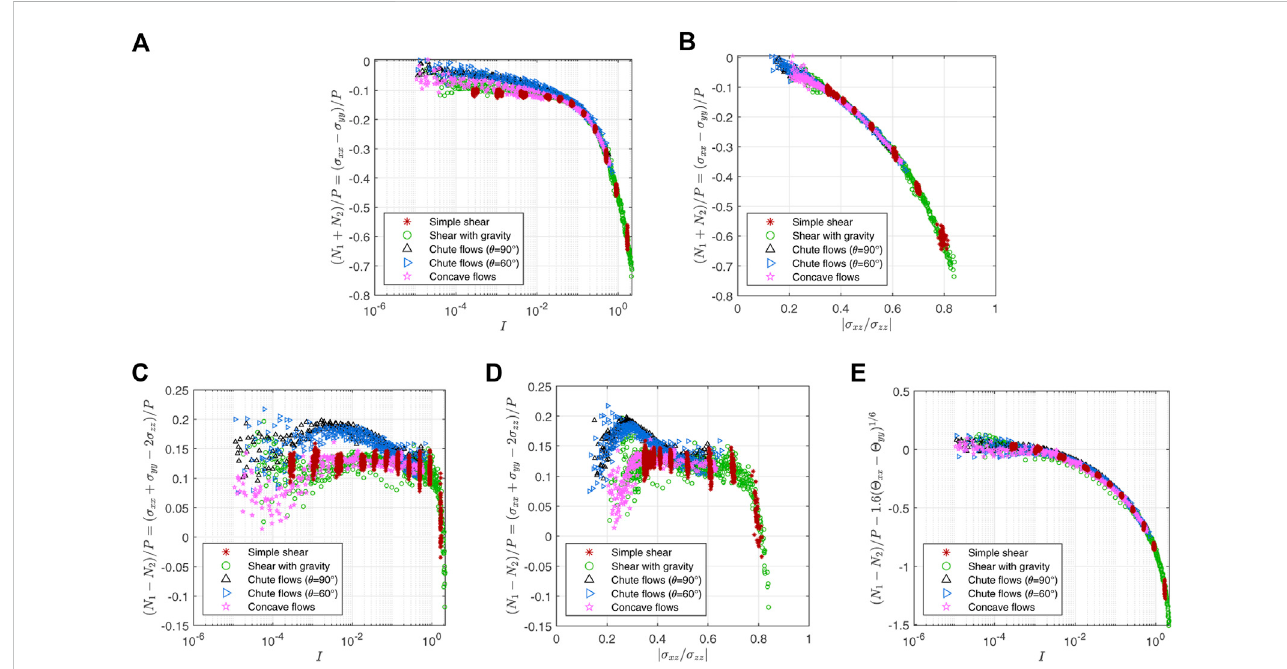
FIGURE 9 Sum and difference of the fi rst ( N 1 ) and second ( N 2 ) normal stress differences divided by pressure: ( N 1 + N 2 )/ P = ( σ xx − σ yy )/ P exhibits non-locality when plotted against I (A) , but it forms a collapsed line when plotted against | σ xz / σ zz | (B) . Plotting ( N 1 − N 2 )/ P = ( σ xx + σ yy − 2 σ zz )/ P against (C) I or (D) | σ xz / σ zz | does not form a data collapse. (E) Subtracting an arbitrary function 1 . 6 ( Θ xx − Θ yy ) 1/6 from ( N 1 − N 2 )/ P seems to collapse the data into a line that depends only on I